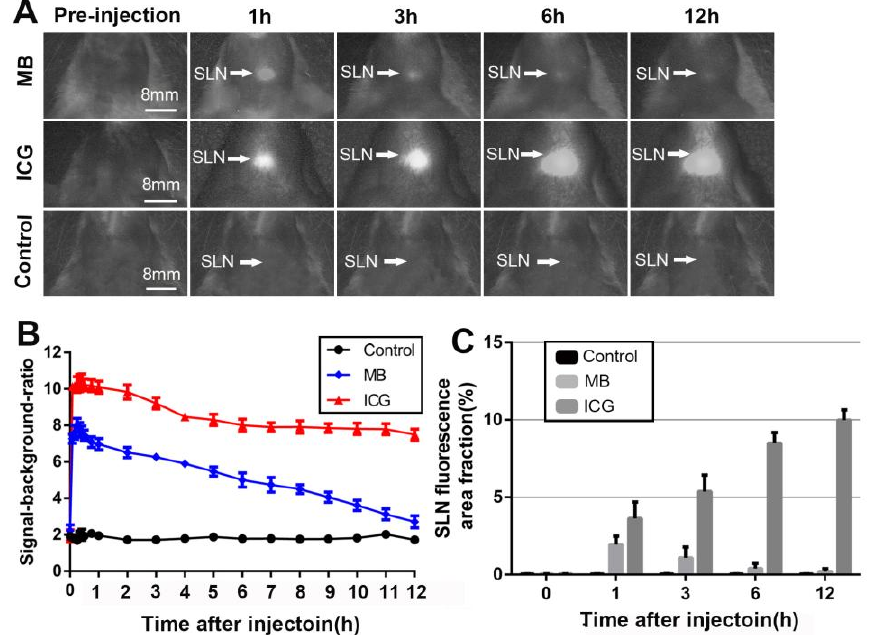
Figure 3. Comparison between MB and ICG for sentinel lymph node mapping using NIR fluorescence imaging in rats. ( A ) Fluorescence images acquired before injection and 1, 3, 6, and 12 h after injection of MB, ICG, and saline in rats. ( B ) Changes in the SBR of different groups (mean ± SD) within the SLN region over time after injection. Differences were observed between different groups ( p < 0.001). ( C ) SLN fluorescence area fraction before injection and 1, 3, 6, and 12 h after injection of different agents. Values with different agents are significantly different from each other ( p < 0.001).